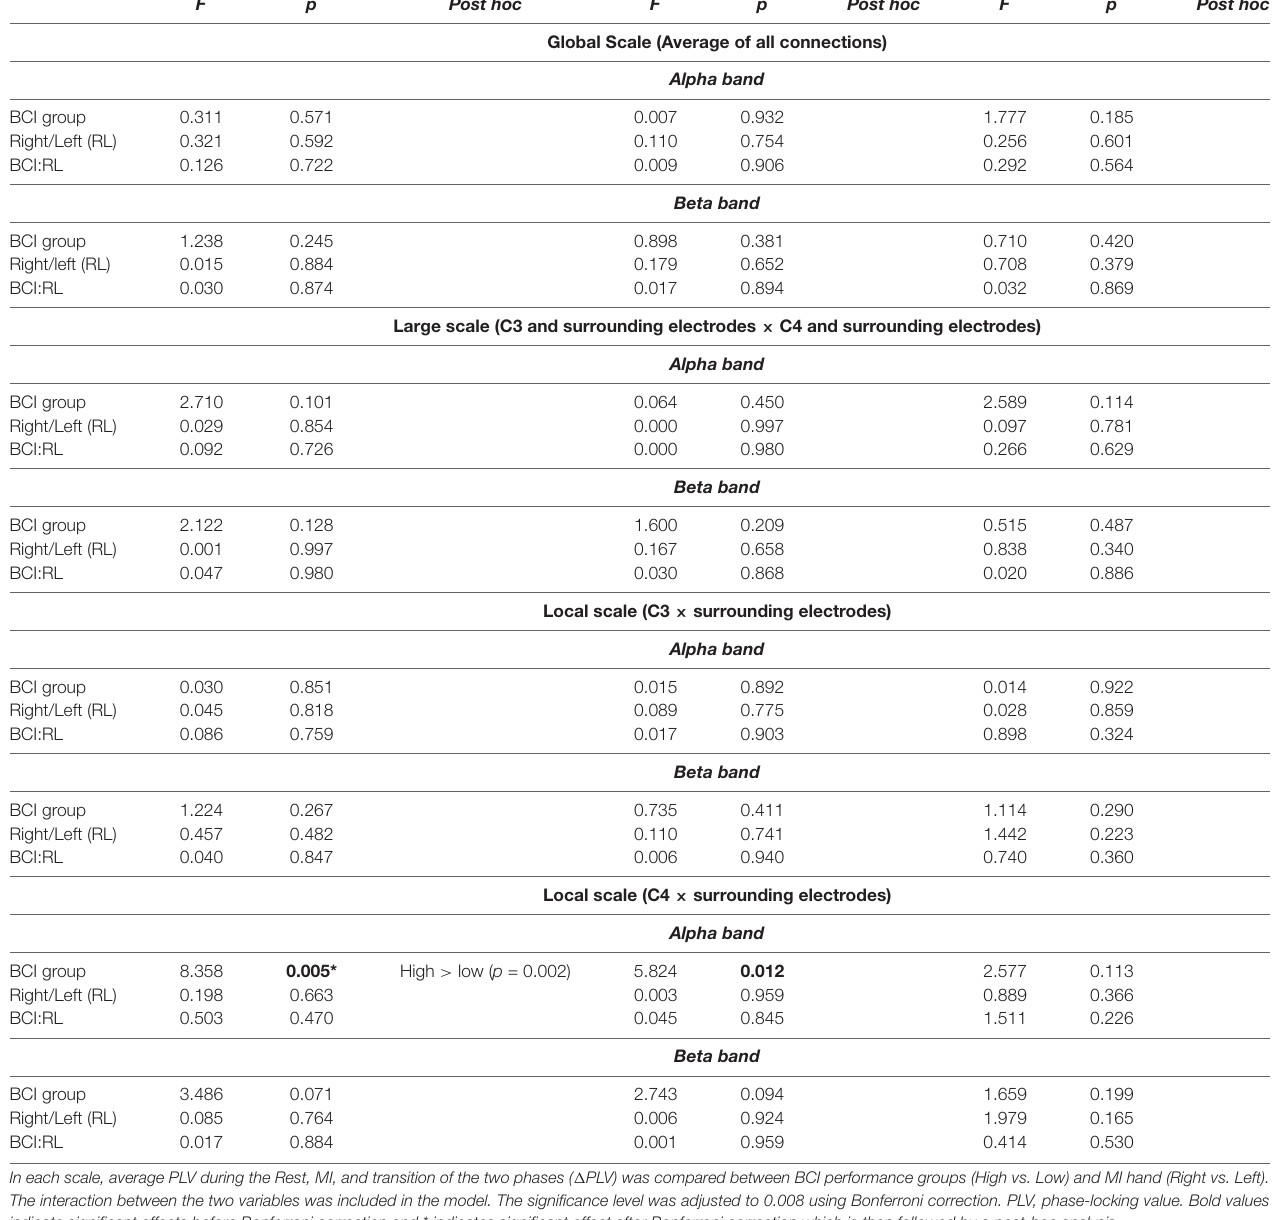
TABLE 2 | Results of the factorial ANOVA for global scale, large scale, and local scale connectivity in the alpha frequency band. PLV MI PLV Rest ∆ PLV F p Post hoc F p Post hoc F p Post hoc Global Scale (Average of all connections) Alpha